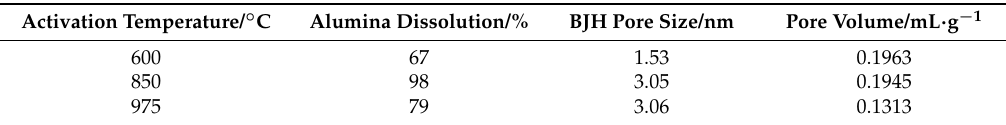
Table 3. Correlation between the pore features of porous silica and alumina dissolution of activated kaolinite.